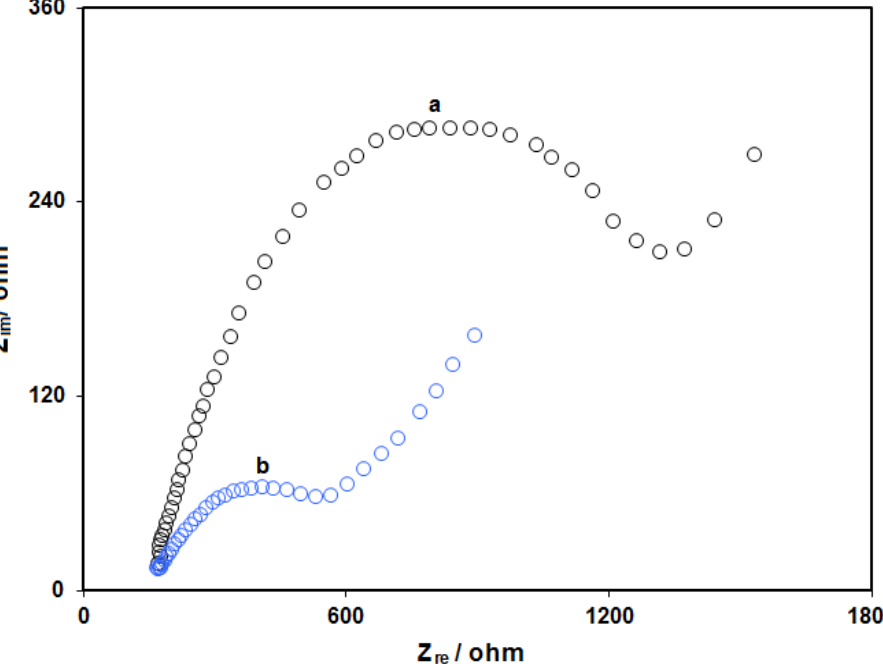
Figure 5. Nyquist diagrams at the bare screen-printed electrode (SPE) (curve a) and the GO/ZIF-67/SPE (curve b) in the presence of 0.5 mM [Fe(CN)6] 3–/4– at pH 7.0.